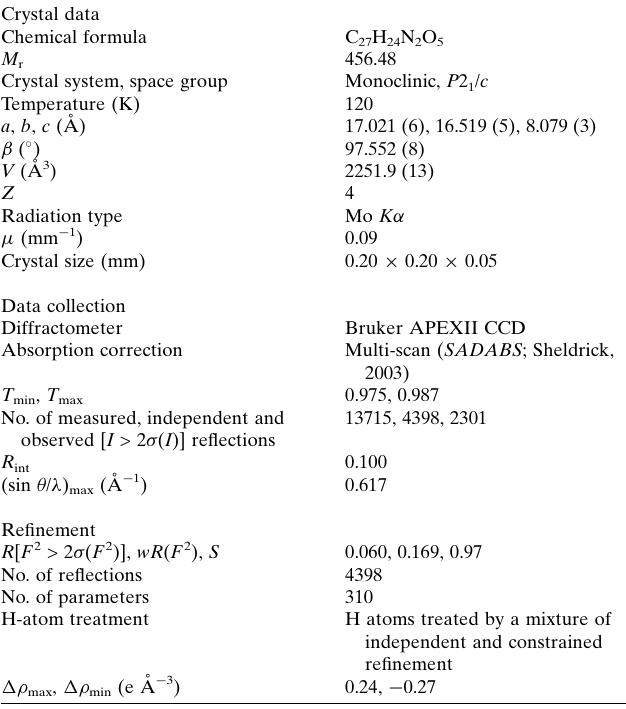
Table 2 Experimental details. Crystal data Chemical